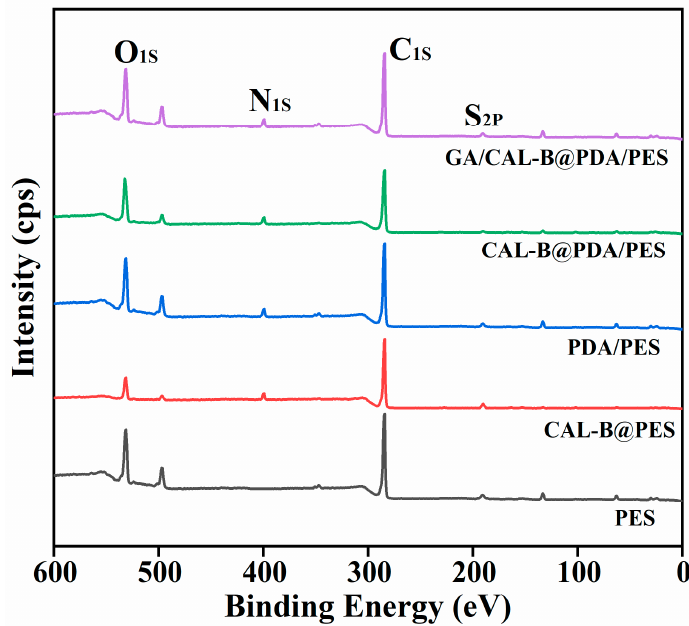
Figure 4. XPS spectrum of the BLIMs.